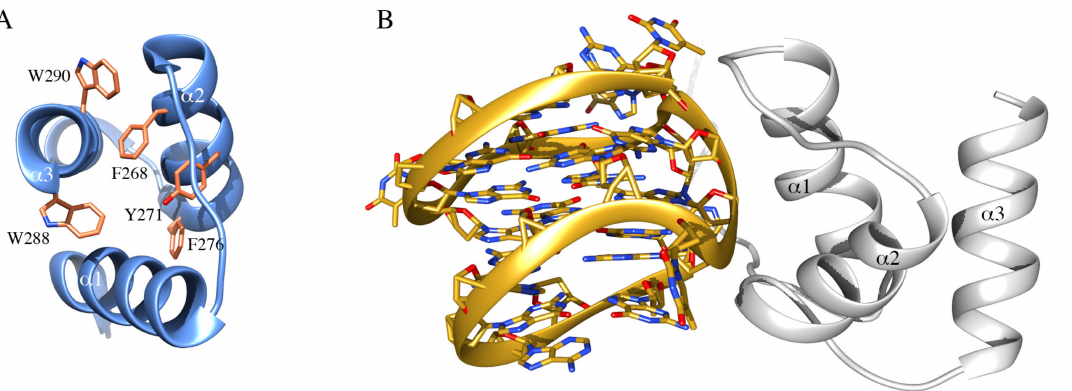
Figure 2. NPM1 C-terminal domain and interaction with nucleic acids. ( A ) The structure of the NPM1 C-terminal domain, consisting of three helices forming a bundle, is represented in ribbon. In sticks are highlighted residues forming the hydrophobic core of the three-helix bundle, including W288 and W290, that are a ff ected by AML-related mutations. ( B ) Structure of the complex between NPM1 CTD (white ribbon) and the G-quadruplex region from the c-MYC promoter (gold ribbon). The phosphate backbone of the G-quadruplex is engaged by a positively charged groove between helices 1 and